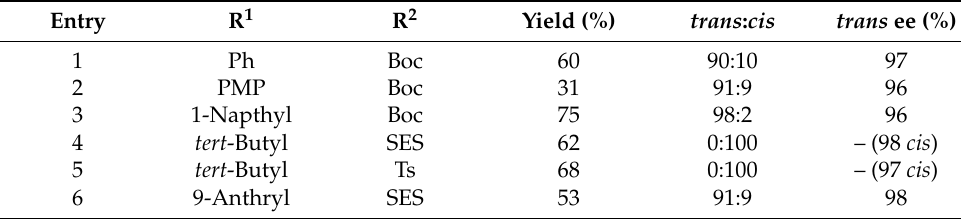
Table 4. Substrate scope of sulfonium salt 2 -mediated aziridination (Scheme